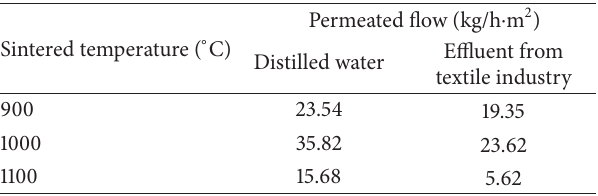
Figure 7: Textile effluent permeated flow of the ceramic membranes sintered at 900, 1000, and 1100 ∘ C. Table 2: Comparative values between the permeated flows from distilled water and industrial effluent.